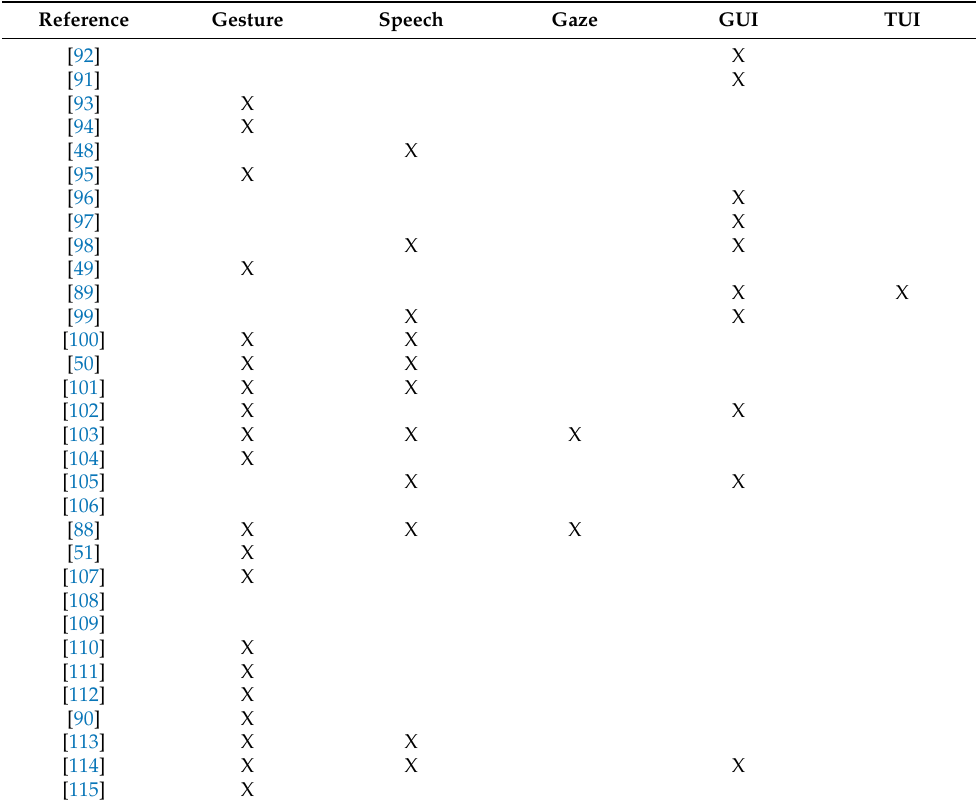
Table 14. User interaction